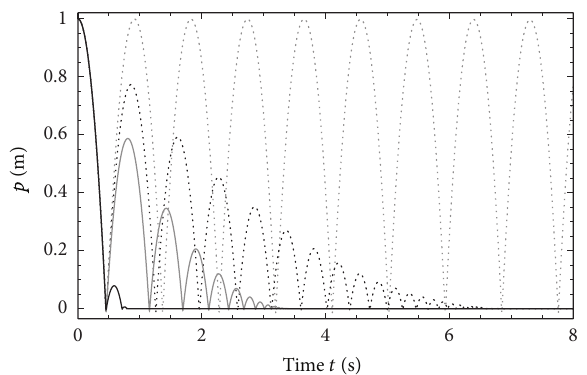
Figure 5: Simulation of the system (27) by RK4 with the timestep size 0.001s. The parameters are chosen as 𝑀 = 1 kg, 𝑓 𝑒 = −9.8 N, 𝐾 = 10 5 N/m, 𝛽 = 0.01 s, and 𝛼 = 0.01 s (gray dashed), 0.007 s (black dashed), 0.005 s (gray solid), and 0.001 s (black solid). The initial conditions are 𝑝 = 1 m, and ̇𝑝 = 0